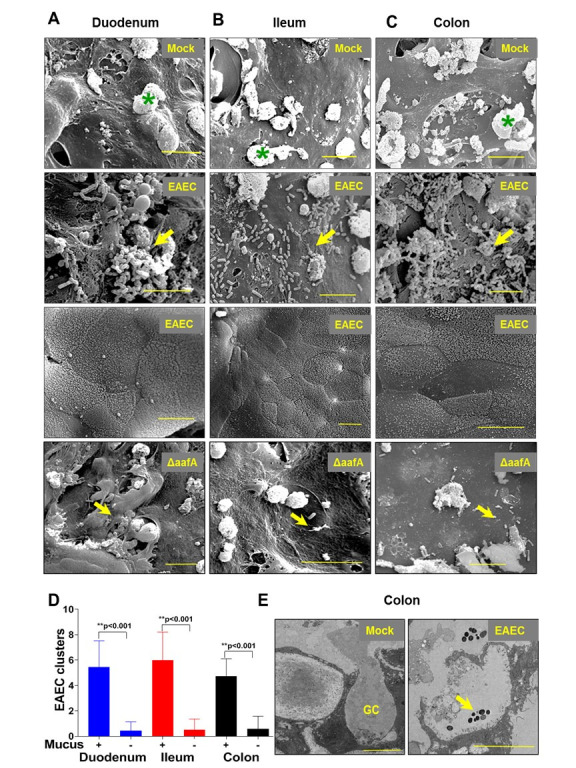
SEM and TEM images of EAEC adherence to human intestinal enteroid monolayers.(A-C) shows SEM image of Mock, EAEC and EAEC: ΔaafA infected duodenal, ileal and colon differentiated HIE monolayers. Row one shows differentiated enteroid monolayers covered by secreted mucus droplets (denoted by the asterisk). Row two shows adherence of EAEC to mucus (yellow arrow) present on the duodenal, ileal and colon monolayers. Row three shows EAEC infected duodenal, ileal and colon monolayers but with no EAEC adherence and without the presence of mucus droplets. Row four shows EAEC: ΔaafA infected duodenal, ileal and colon monolayers. (D) Quantification of the EAEC aggregates in the presence and absence of mucus droplets on enteroid monolayers was quantified from average of 12 images taken at 1700x and error bars denote SEM and *** indicates significantly different (P<0.001). (E) TEM of colonoid monolayers showing vesiculation of Goblet Cell (GC) mucus and EAEC adherence to GC mucus (yellow arrow). Scale bars indicate 10μm.